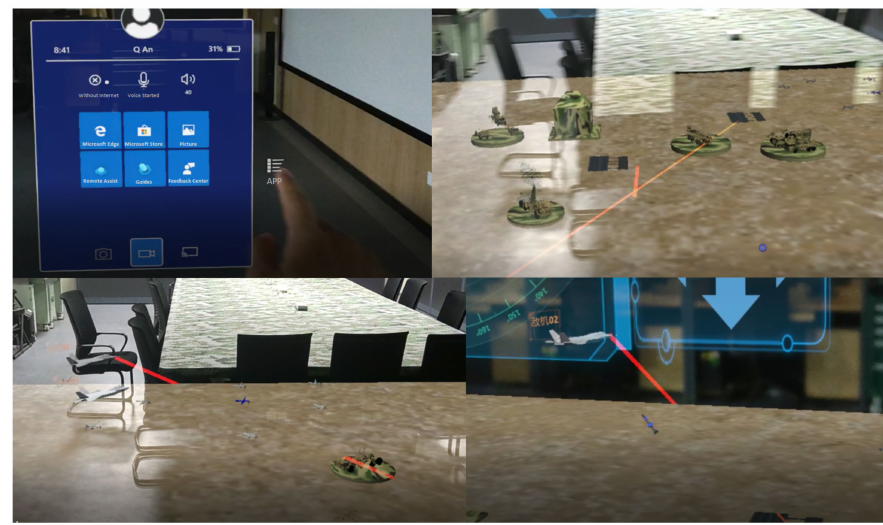
Figure 13. The first perspective of the experimenter using the HoloLens2 to complete the task.